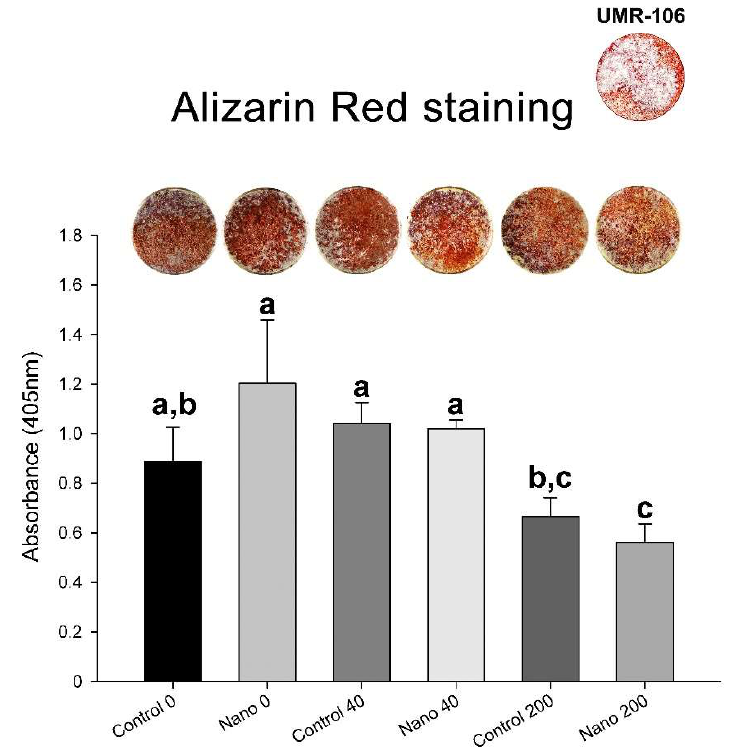
Figure 6. Macroscopic imaging and biochemical analysis (calcium content) of Alizarin-Red-stained mineralized matrix formation of UMR-106 cell cultures grown on Control-Ti and Nano-Ti on day 7 of culture, exposed or not on days 2 and 4 of culture to 40 and 200 ng/mL BMP-7 in the culture medium. Bars that share one letter are not significantly different from each other ( p > 0.05).